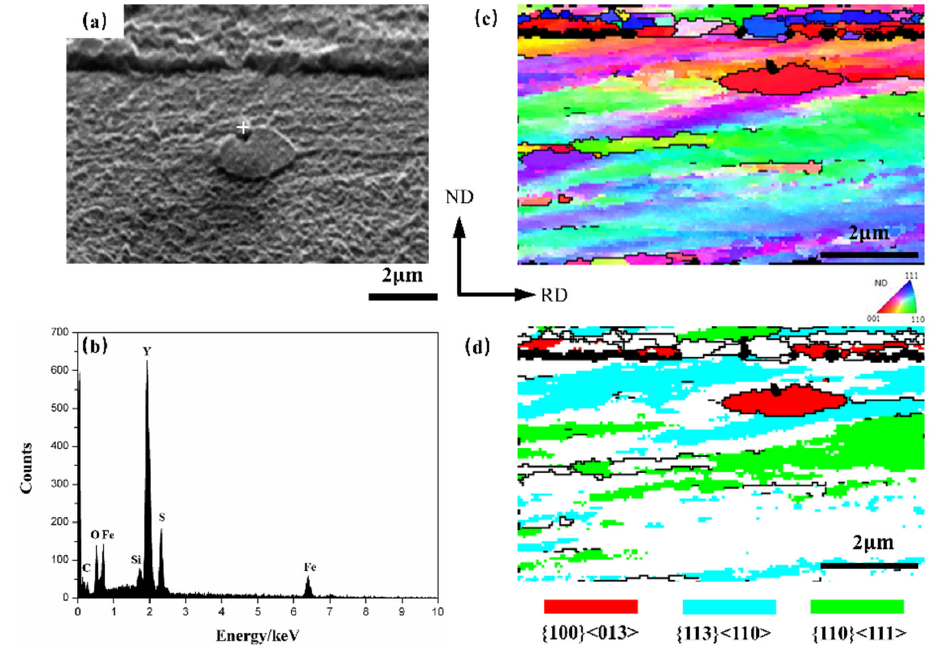
Figure 6. Recrystallization around a Y 2 O 2 S inclusion. ( a ) SEM micrograph; ( b ) EDS result; ( c ) IPF map; and ( d ) main texture components.